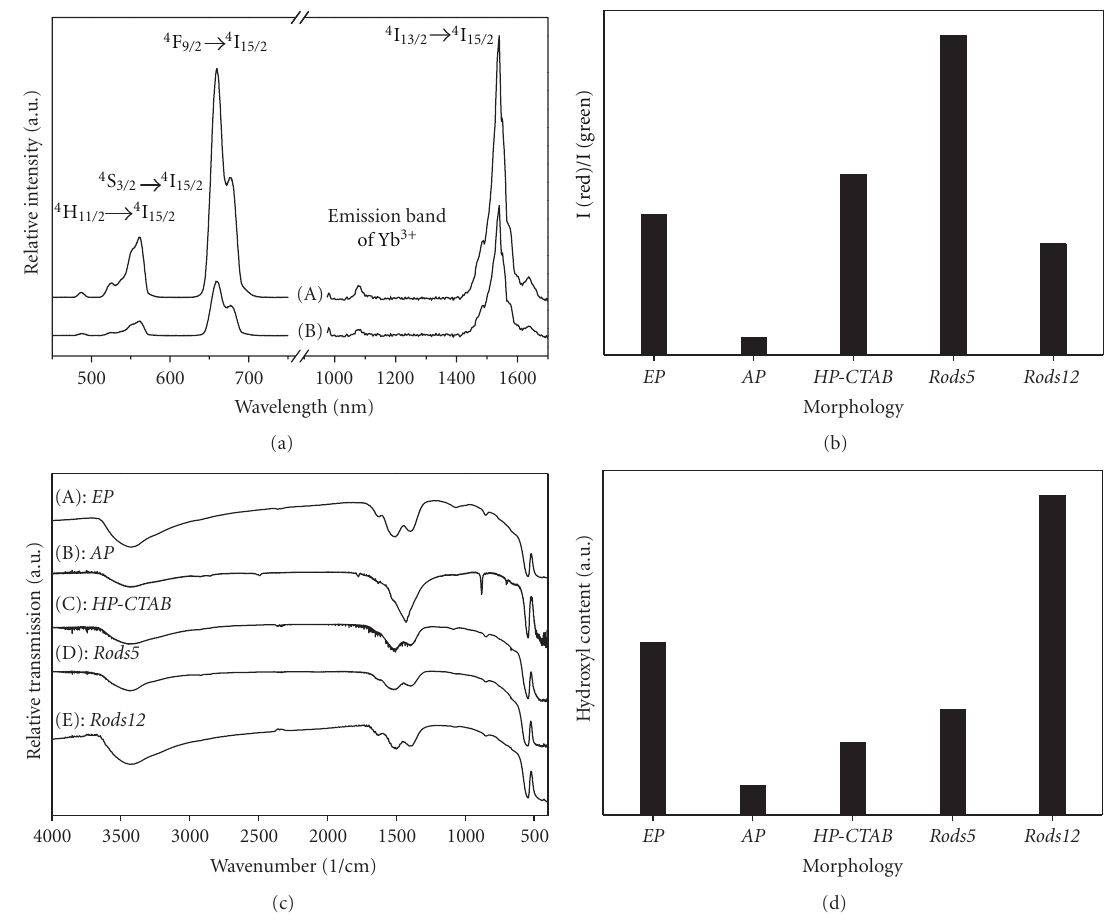
Figure 4: (a) Upconversion ( λ ex = 980 nm, P Laser = 600mW) and NIR ( λ ex = 980 nm, P Laser = 100 mW) emission of ParticlesHP-CTAB (A) and Rods5 (B) (Similar spectra have been obtained for all other samples). (b) Ratio between the red and green emission intensities. (c) Normalized FT-IR spectra recorded on (A) ParticlesEP , (B) ParticlesAP , (C) ParticlesHP-CTAB , (D) Rods5 and (E) Rods12 . (d) Peak area at 3500 cm − 1 representing the hydroxyl content of the